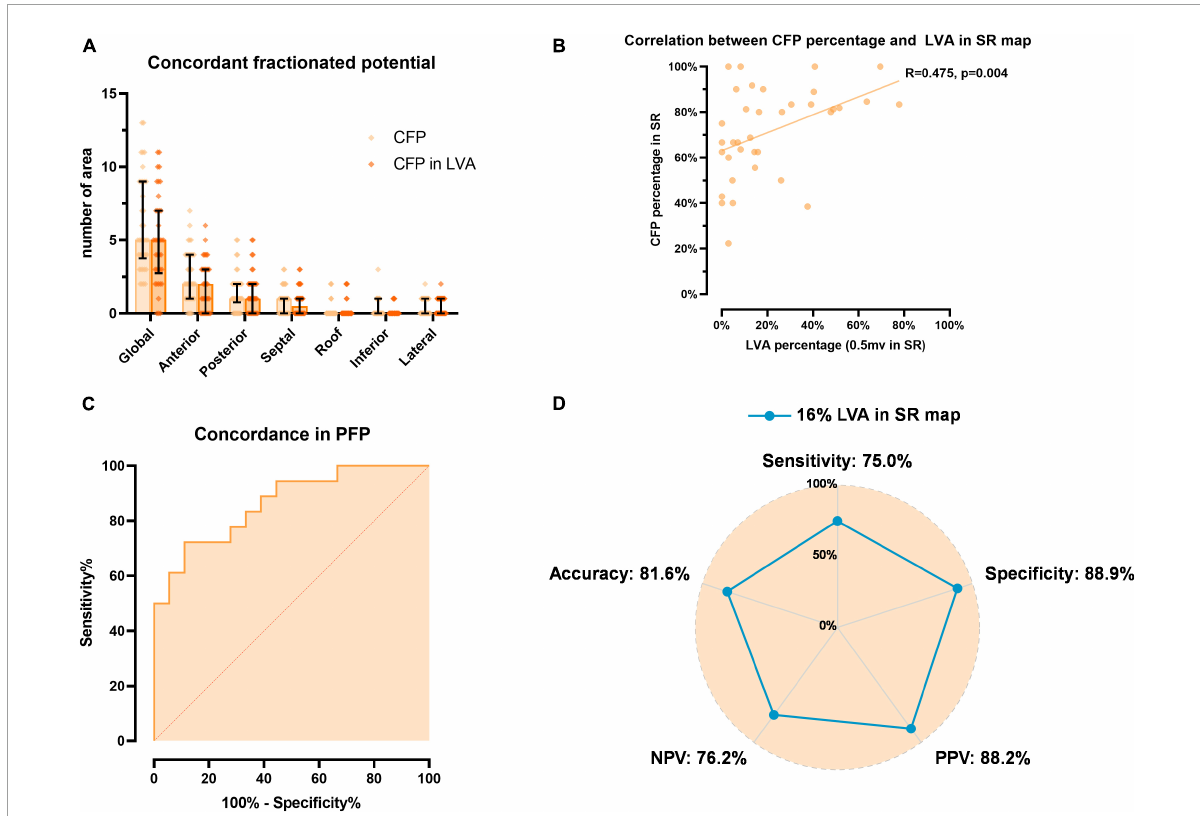
FIGURE4 Evaluation of concordance of fractionated potentials (CFP). (A) Illustrates the distribution of areas presenting CFP and those located in LVA in SR map. (B) Displays the correlation between percentage of CFP in PFP-SR and LVA extent in SR map. (C) Displays the ROC curve of high concordance ( > 80%) between PFP-AF and PFP-SR, which is predicted by LVA extent in SR. (D) Illustrates the diagnostic performance of optimal LVA extent threshold (16% of LA displaying LVA) to predict high concordance of fractionated potentials. CFP, concordance of fractionated potentials; LVA, low voltage area; PFP, prolonged fractionated potential; SR, sinus rhythm; AF, atrial fibrillation; LA, left atrium; PPV, positive predictive value; NPV, negative predictive value.